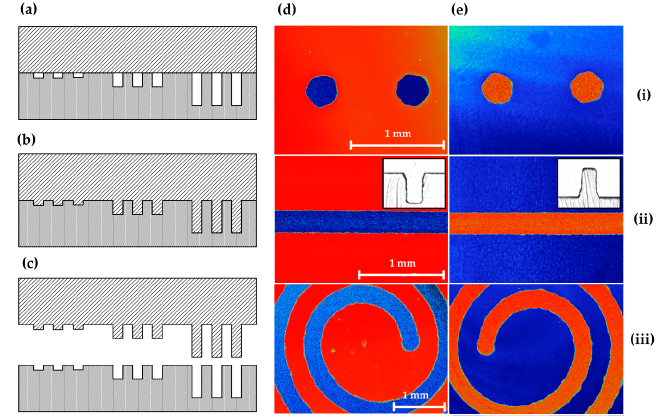
Figure 5. The process of embossing includes ( a ) putting a polymer sheet in light contact with the glass template while the system temperature is elevated to T e . ( b ) After stabilization of temperature, embossing pressure is applied and the heated polymer conforms to the template bas-relief features. ( c ) After cooling to T d , the master is separated from the patterned polymer. Optical profilometry of ( d ) features on the glass template and ( e ) the embossed PC substrate for vertical drill holes ( i ), straight trenches ( ii ), and spiral pattern ( iii ). Red and blue colours show raised and recessed surfaces, respectively. Inset figures for straight trenches in glass and the corresponding embossed PC were common for the corresponding image in ( e ). acquired from microscopy of cross-sections. Scale bars for template images ( d ) are each 1 mm and common for the corresponding image in ( e